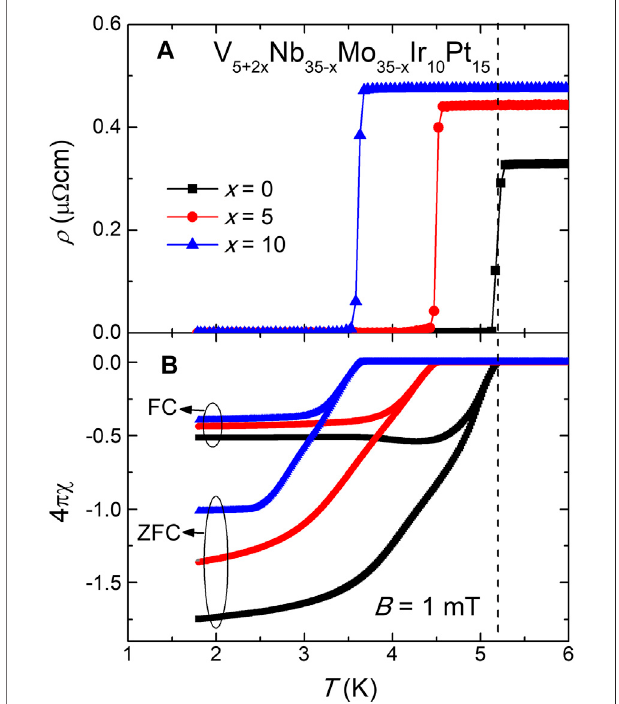
FIGURE 3 | (A) Temperature dependence of resistivity for the V temperature range. The ZFC as well as FC curves are labeled, and the vertical dashed line is a guide to the